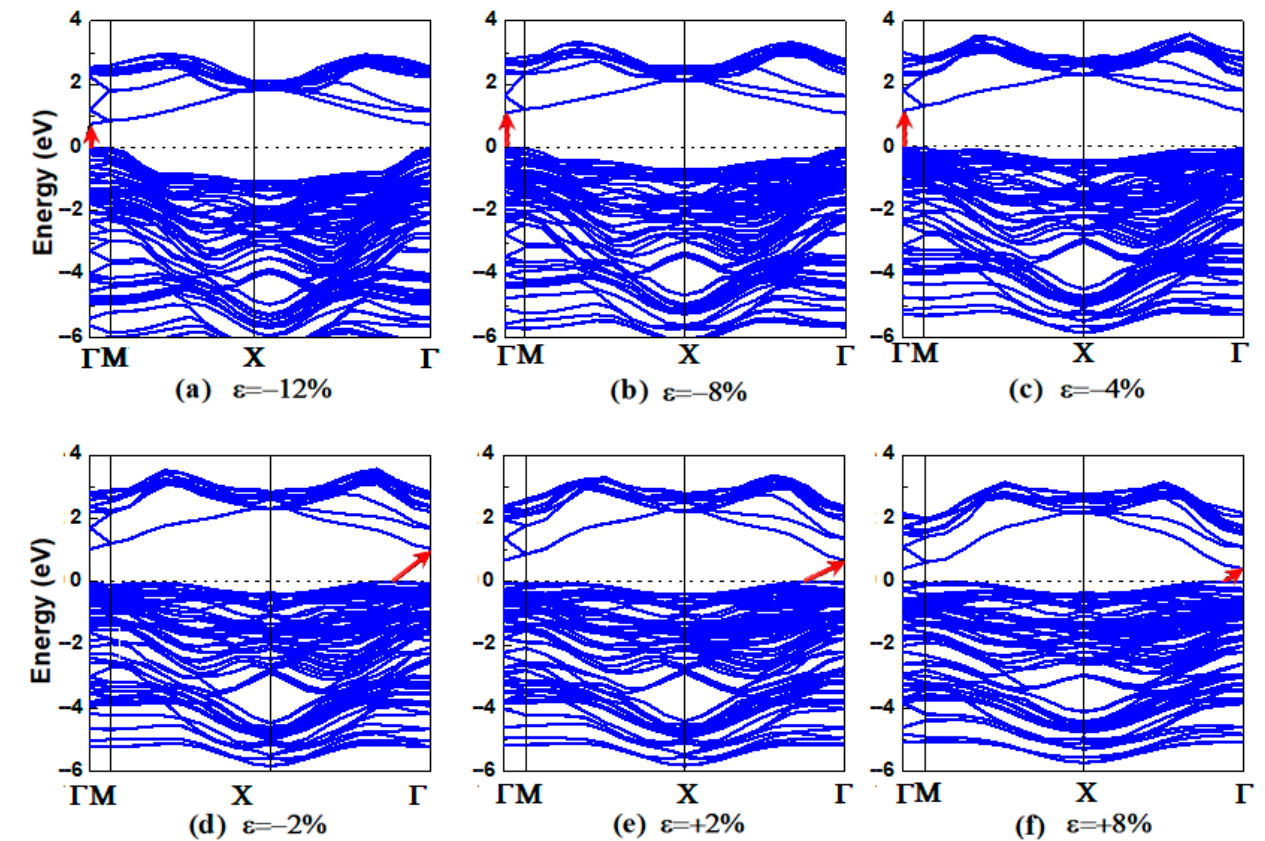
Figure 8. Band structure change and the band edge shift under biaxial strain for the T/V-AlP bilayer based on HSE functional. In the case of compression, figures ( a – c ) show direct band gaps (vertical arrows), while in the case of tension, figures ( d – f ) show indirect band gaps (diagonal arrows).